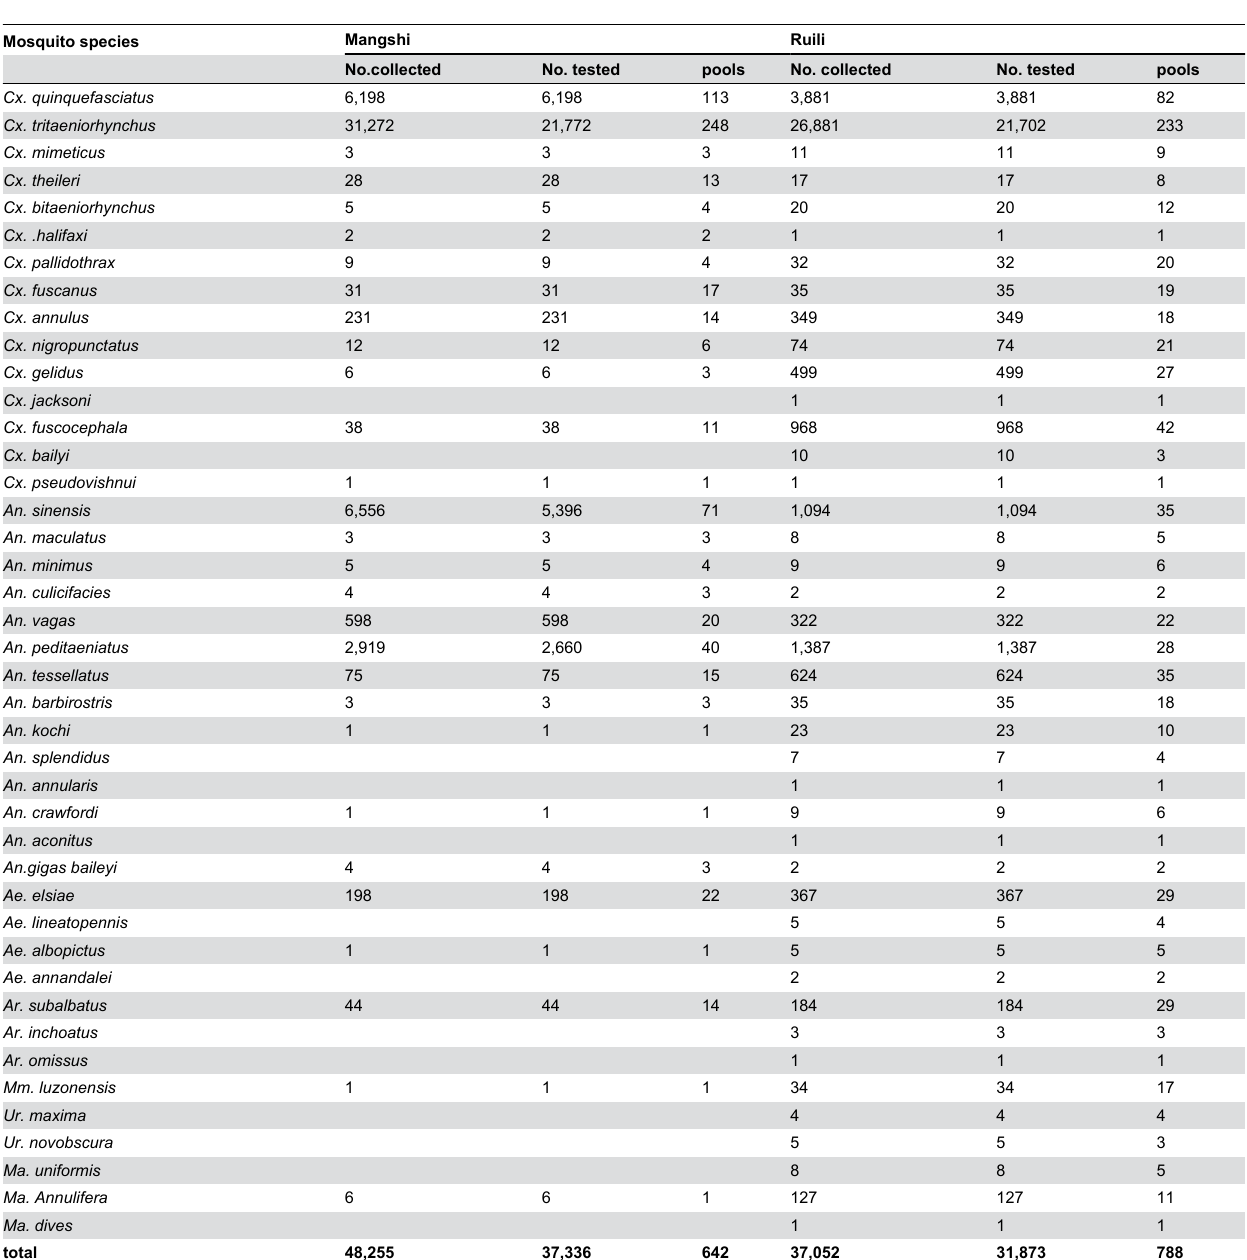
Table 5. Summary of mosquito species collected and tested for virus in Mangshi and Ruili during Jan-Dec, 2010.